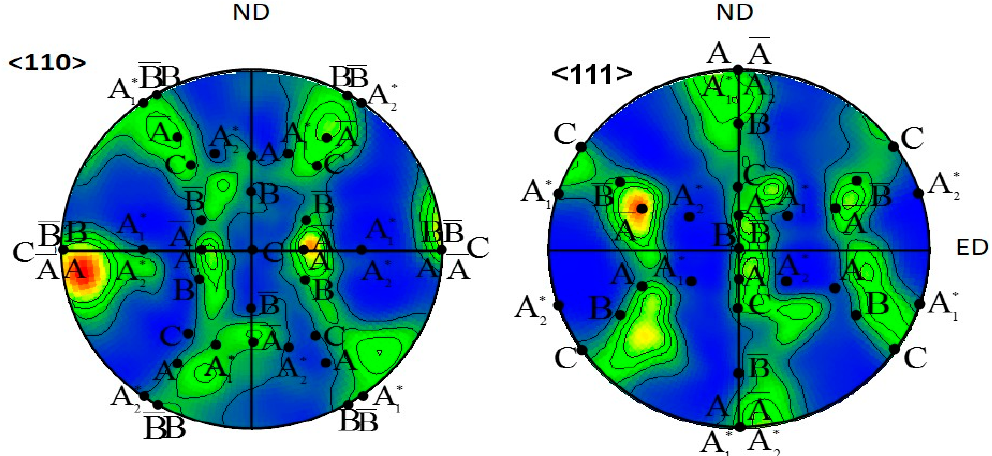
Table 2. Partial fibers and ideal components of simple shear texture in fcc metals [45–55]. Figure 10. (111) and (110) pole figures of commercial pure Cu after processing through 4-Bc_RT with the ideal simple shear texture components superimposed (for interpretation of the references to color in this figure legend, the reader is referred to the web version of the article).